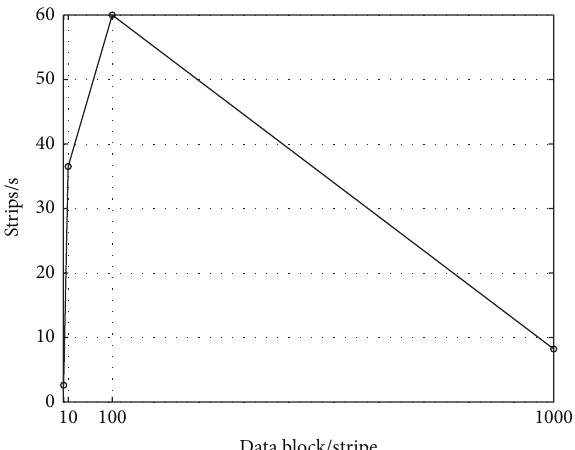
Figure 10: The effect of the size of transmitted data block.